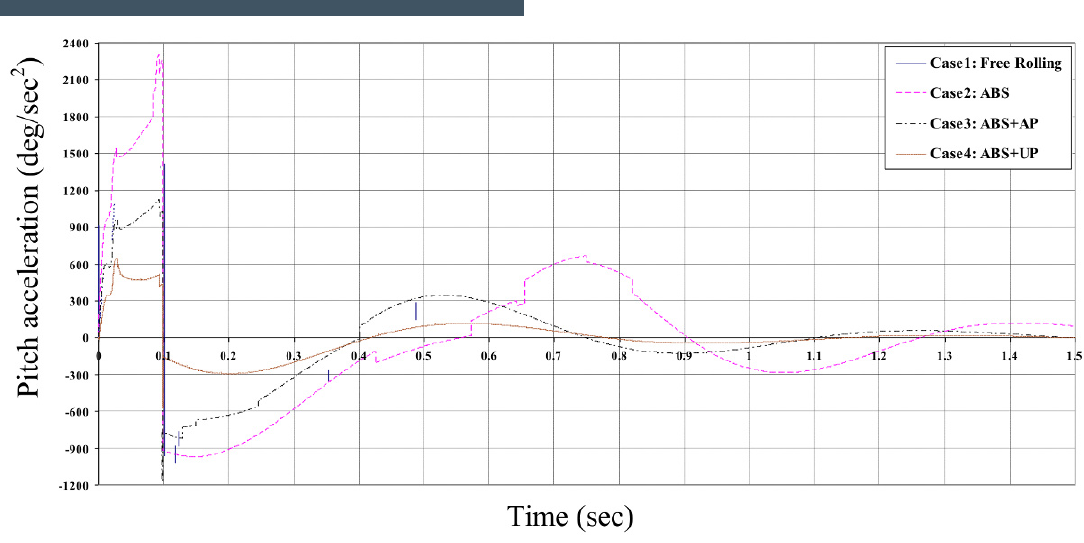
Figure 20. Pitch acceleration of the vehicle body for all cases at offset collision and speed of 70 km/hr.